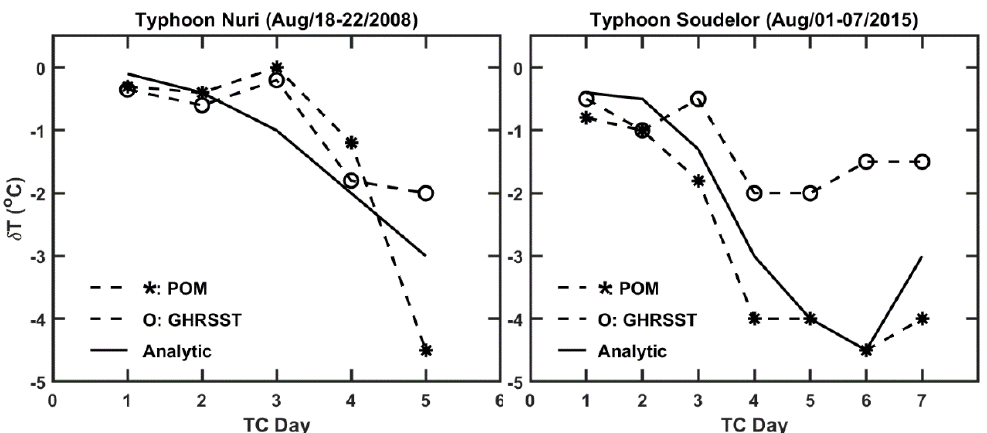
Figure 4. Comparisons of the analytical SST cooling (with γ = 0.02) with GHRSST (Group for High resolution Sea Surface Temperature, https://www.ghrsst.org/ accessed on 1 October 2021) and three-dimensional POM simulated cooling along the daily track of Typhoons Nuri [49,50] and Soudelor [16]. Note that due to interpolation GHRSST tends to underestimate TC‐induced SST cooling [49]. For Nuri, the discrepancy on Day 3 is due to the storm crossing the warm Kuroshio in the Luzon Strait, which the simple model poorly represents.